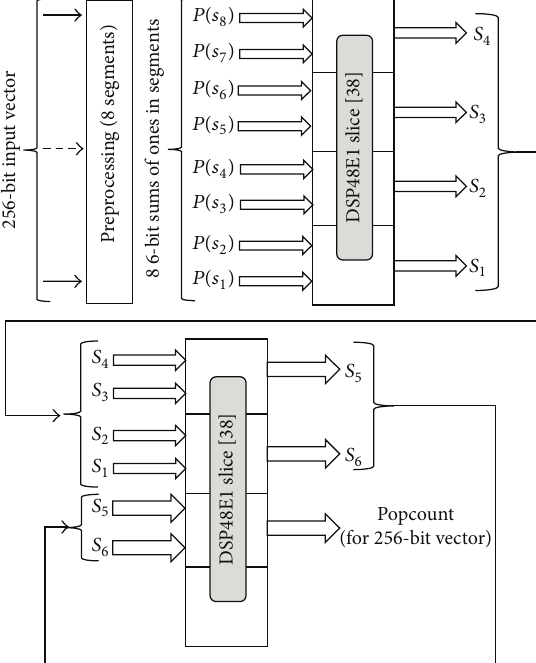
Figure 5: An example of popcount computations for 𝑁 = 256 and 𝜂 = 32